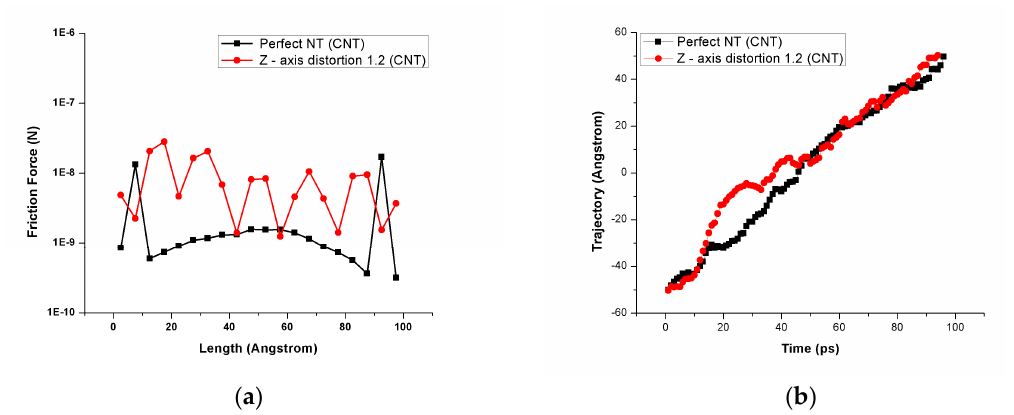
Figure 10. ( a ) Friction force inside the perfect nanotube and Z-distortion 1.2 CNT. ( b ) Comparison of water molecule trajectory inside perfect CNT and CNT with Z-distortion value 1.2.